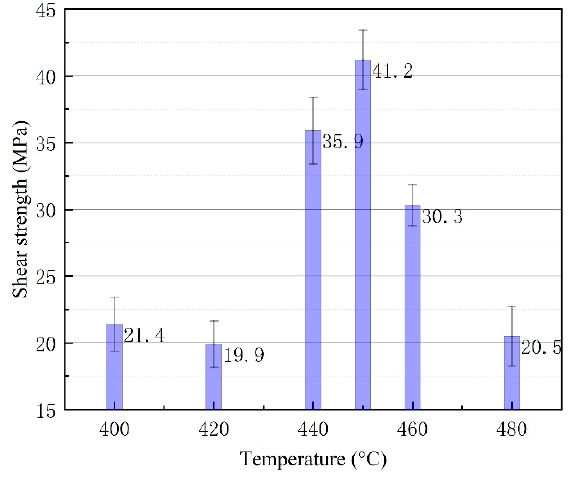
Figure 8. Shear strength of diffusion joints made at different temperatures.